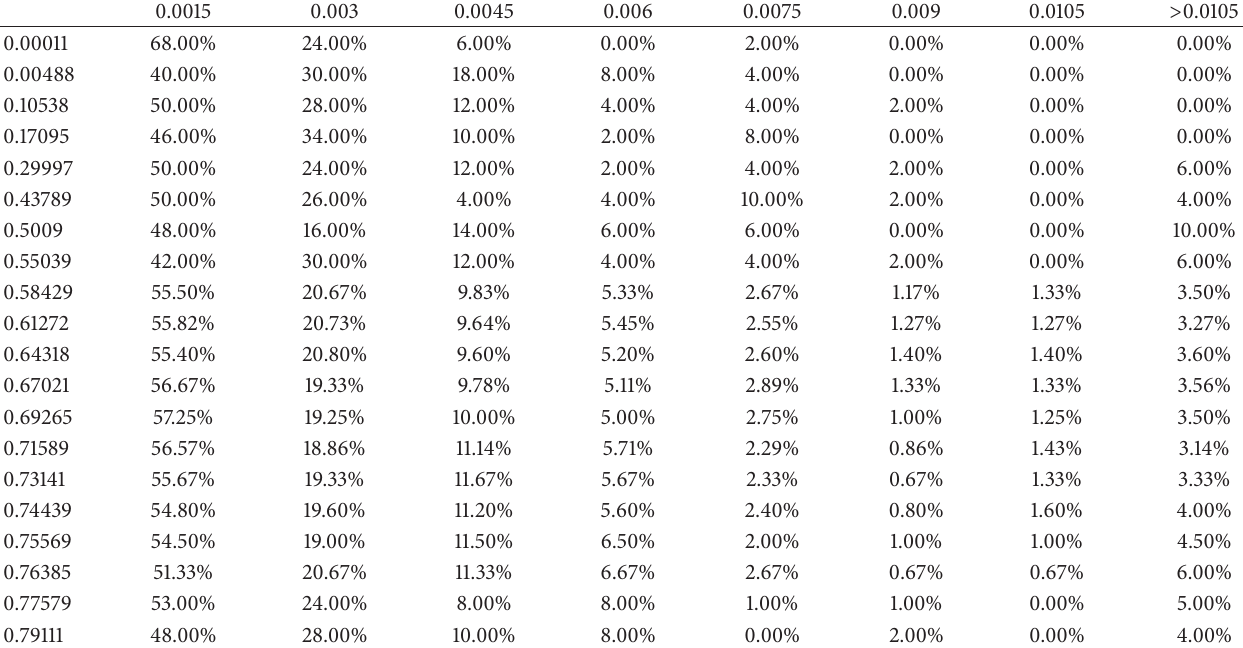
Table 1: Absolute yields under VPIN conditions when the proportion of informed investors is 1/6.